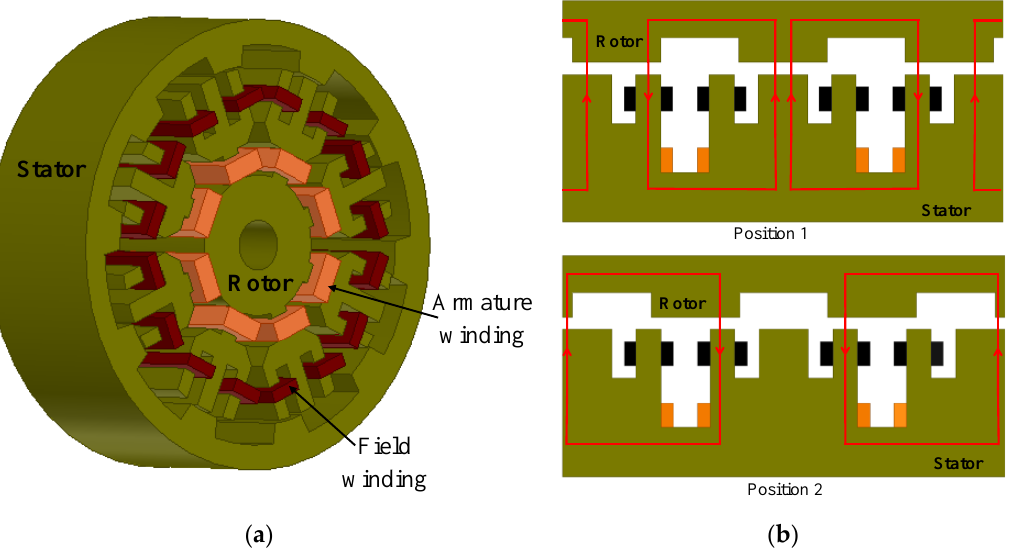
Figure 7. 8/10-pole four-phase outer rotor FRWFM: ( a ) basic topology; ( b ) operating principle. Operating